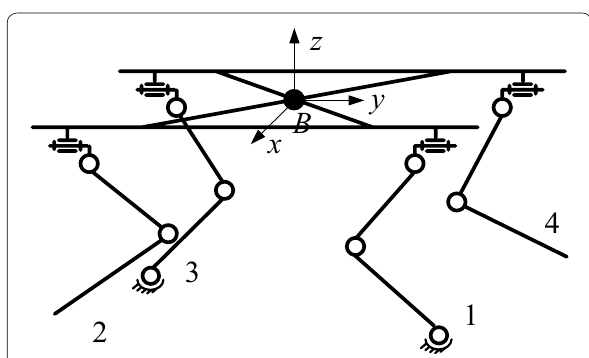
Figure 5 Equivalent mechanism of robot in step forward stage of trotting gait